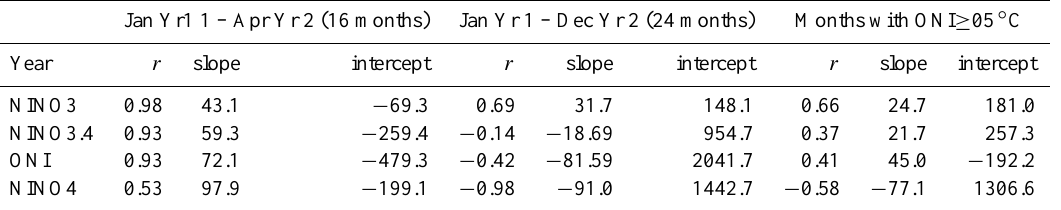
Table 5. Correlation ( r ) between time-integrated El Ni˜no strength (as measured by the ONI, NINO3, NINO4, NINO3.4 ENSO index anomalies) and fire activity (AF counts) integrated over the same time period. Results are shown for the five consecutive El Ni˜no events studied here (1982–1983 to 1997–1998); the two most significant in terms of El Ni˜no strength being those of 1982–1983 and 1997–1998. Three integration periods are tested (1) the 16 months from the start of ENSO Year 1 to the end of the 2nd fire sub-season in April ENSO Year 2, (2) the full 24 months of ENSO Year 1 and ENSO Year 2, and (3) the months showing ONI ≥ 05 ◦ C for each ENSO event (this metric covers different numbers of months in each ENSO episode) as detailed in Table 1.